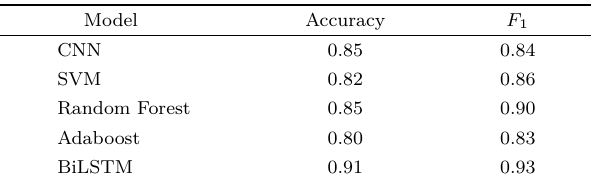
Table 1 Classification model